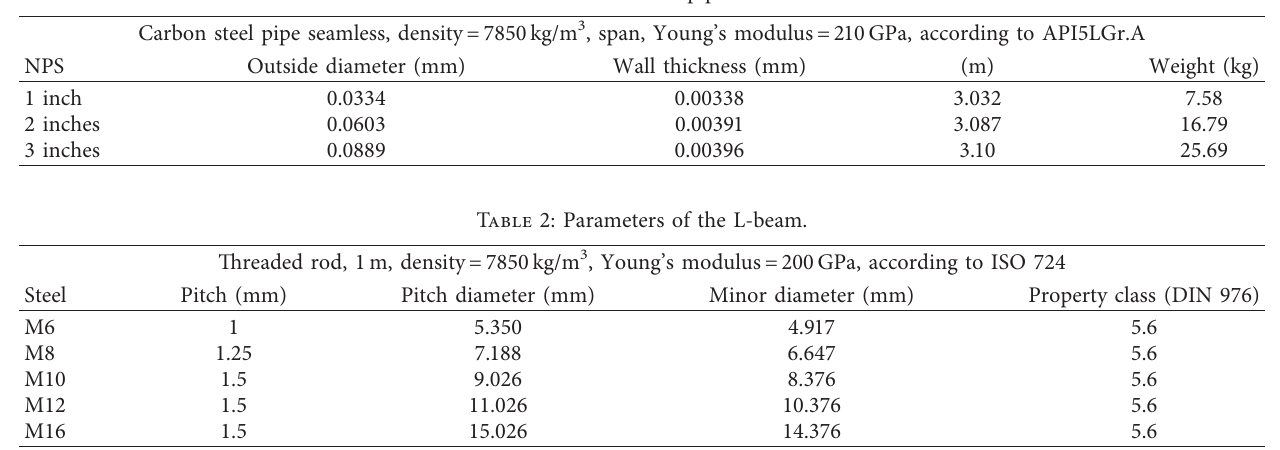
Figure 2: Picture of the experimental setup. Table 1: Parameters of the pipeline structure.